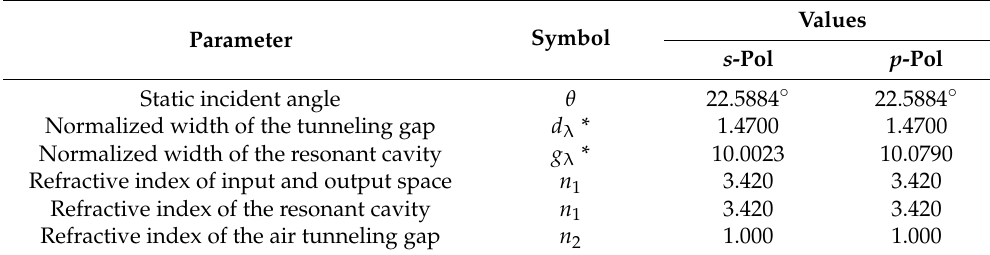
Table 2. Design parameters of the ROTE